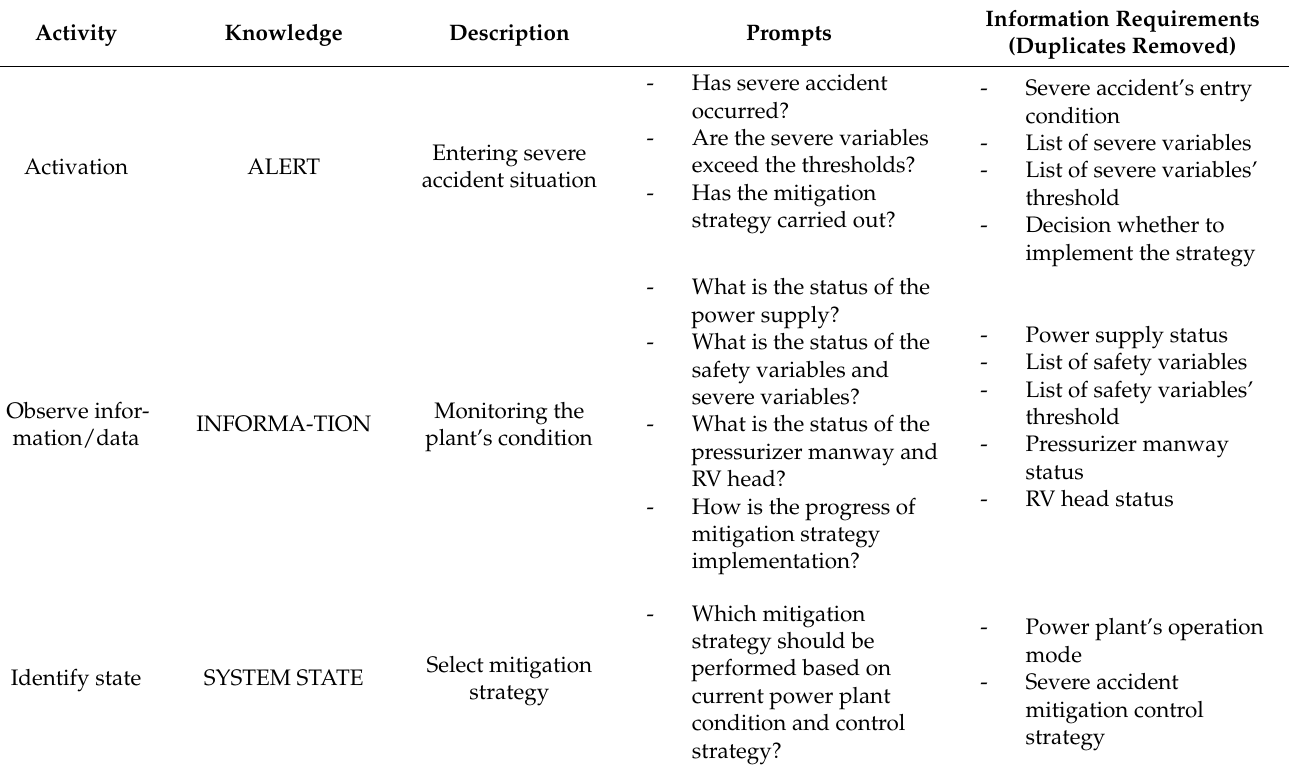
Table 3. Information requirements elicitation from the mapped decision